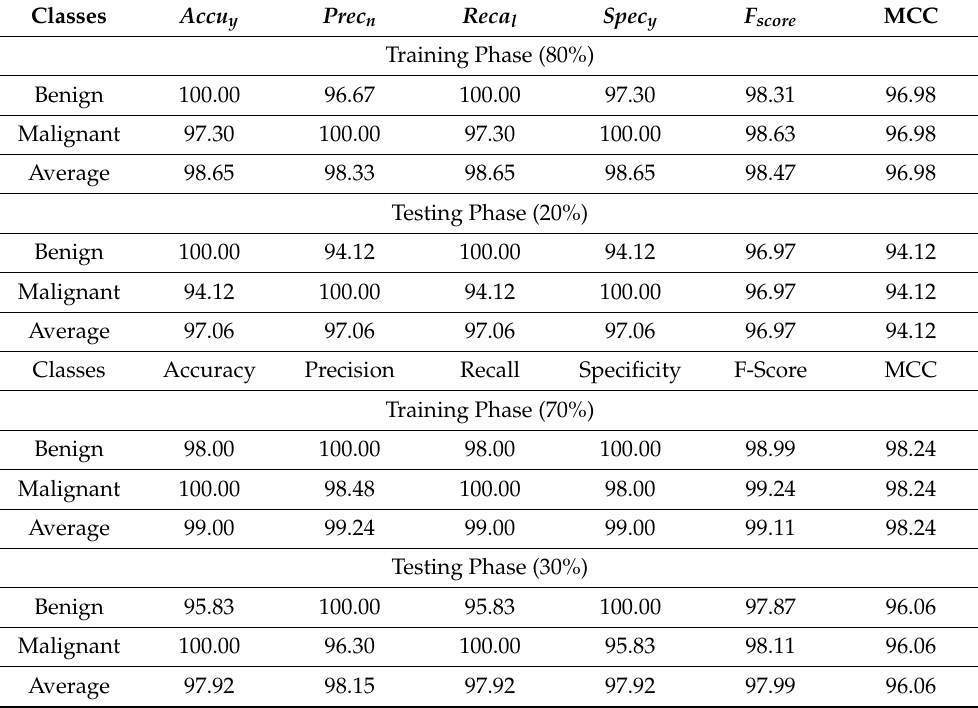
Table 1. Classifier outcome of the AAOXAI-CD approach on dataset-1.